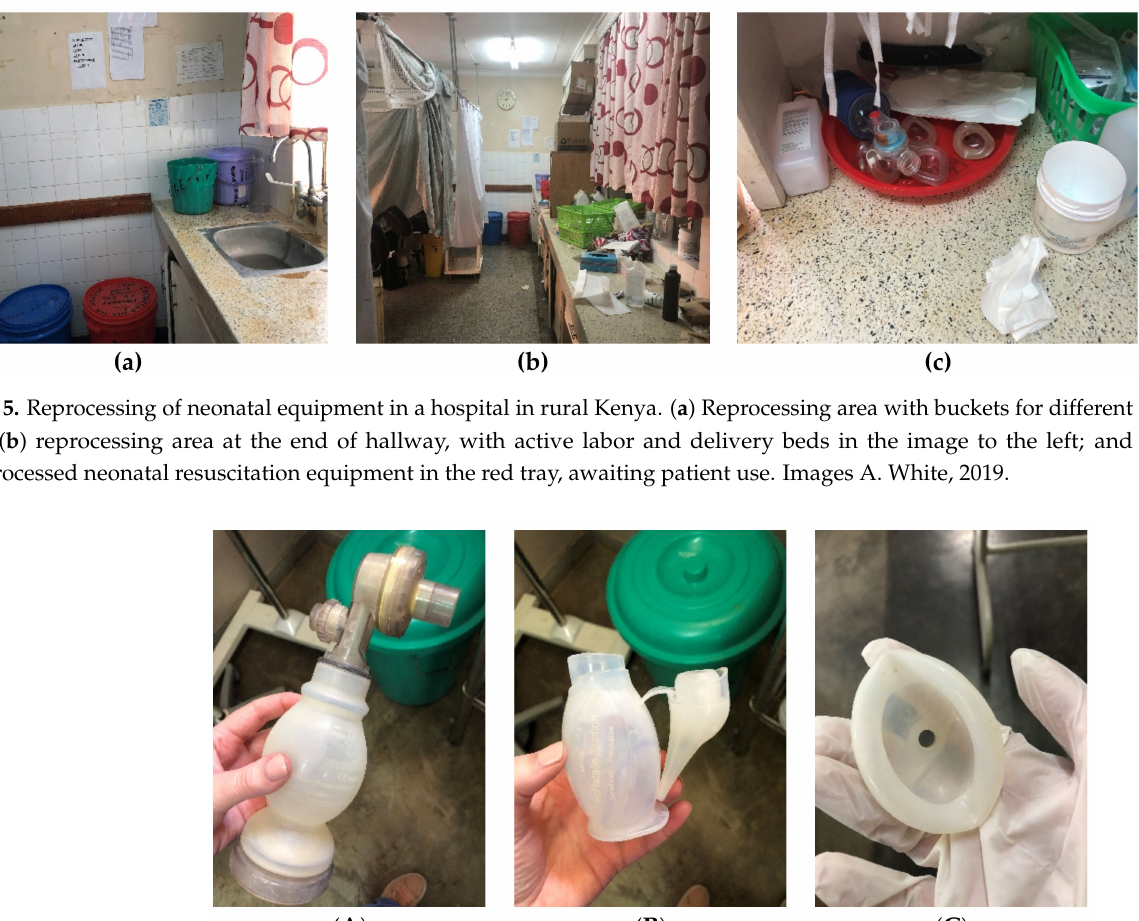
Figure 4. Process map of reprocessing of neonatal equipment at a hospital in Malawi.